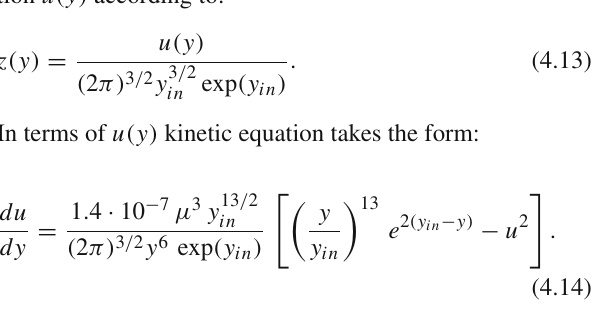
Fig. 4 Evolution of u ( y ) for μ = 100 (left) and μ = 50 (right)